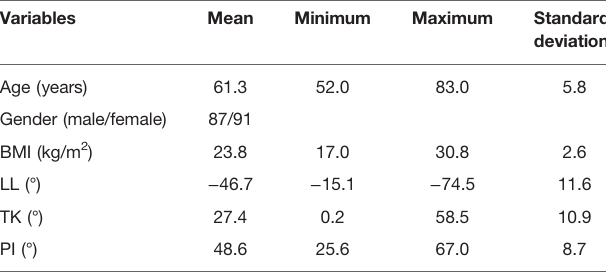
TABLE 1 | Demographic and spinopelvic parameters of the asymptomatic subjects. Variables